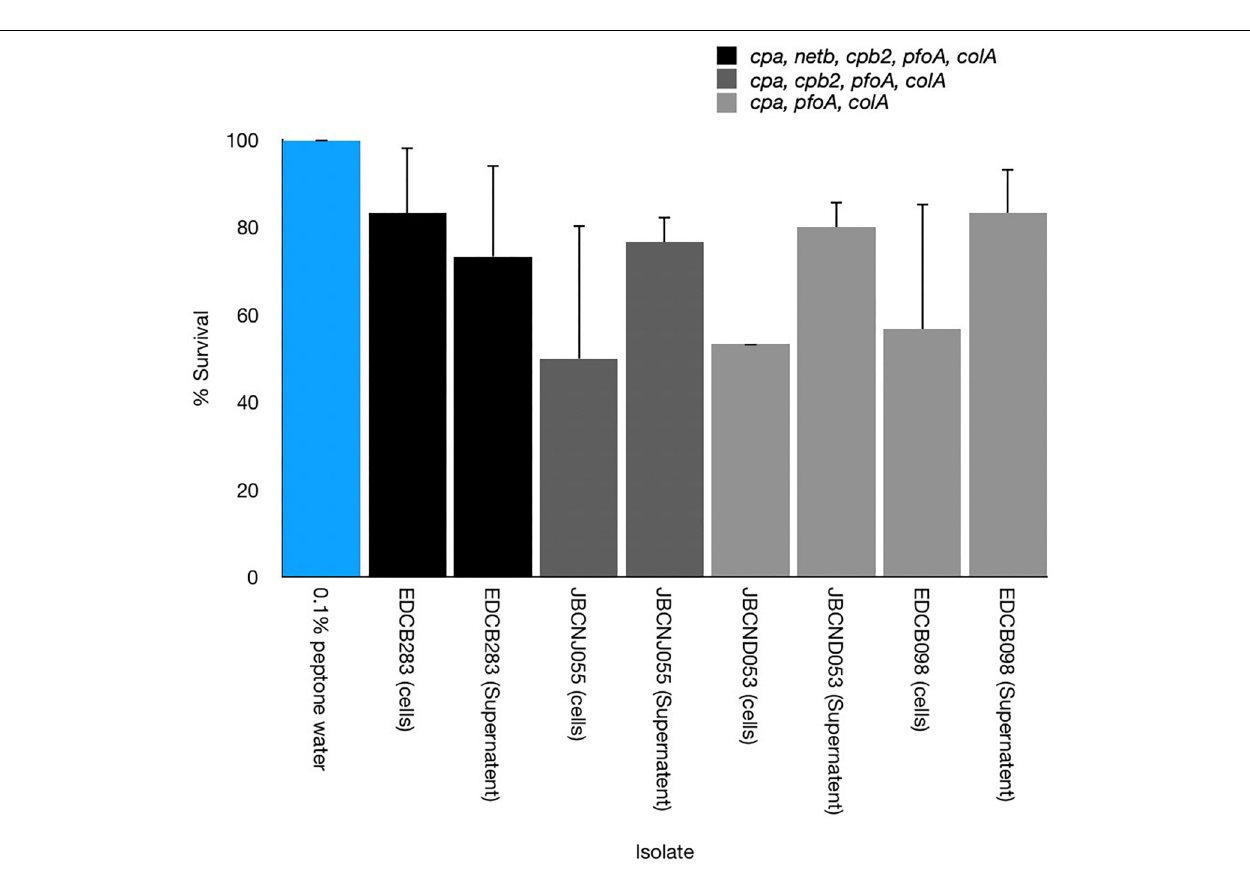
Frontiers in Microbiology |